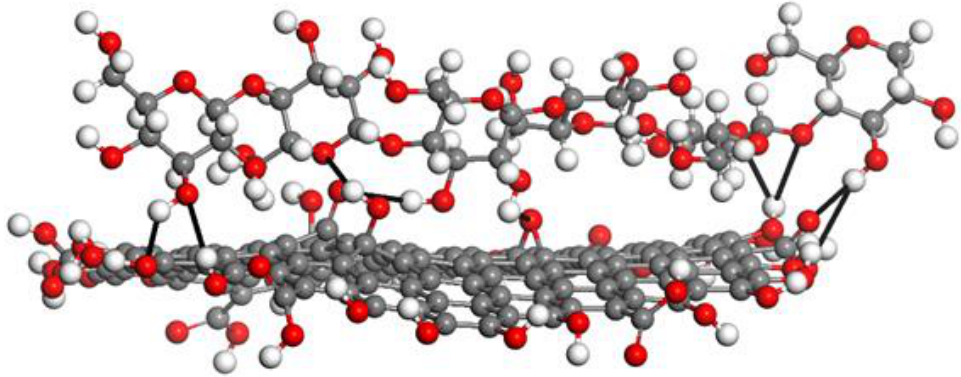
Figure 14. Schematic diagram of hydrogen bonds (black bold line) between the GO (bottom) and CEL macromolecular chains (top). Grey balls—carbon, white balls—hydrogen, red balls—oxygen.